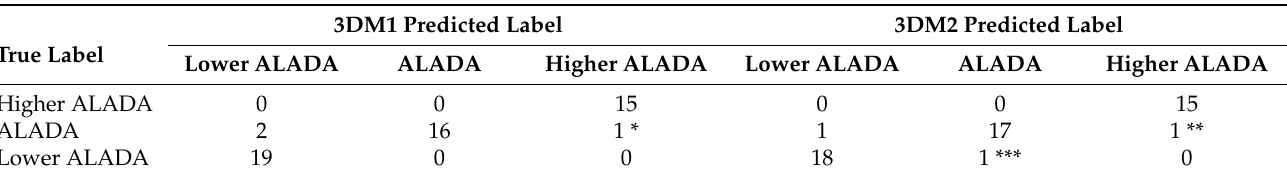
Table 7. The confusion matrix for the prediction of 3DM1 and 3DM2 that shows the number of data objects that were correctly